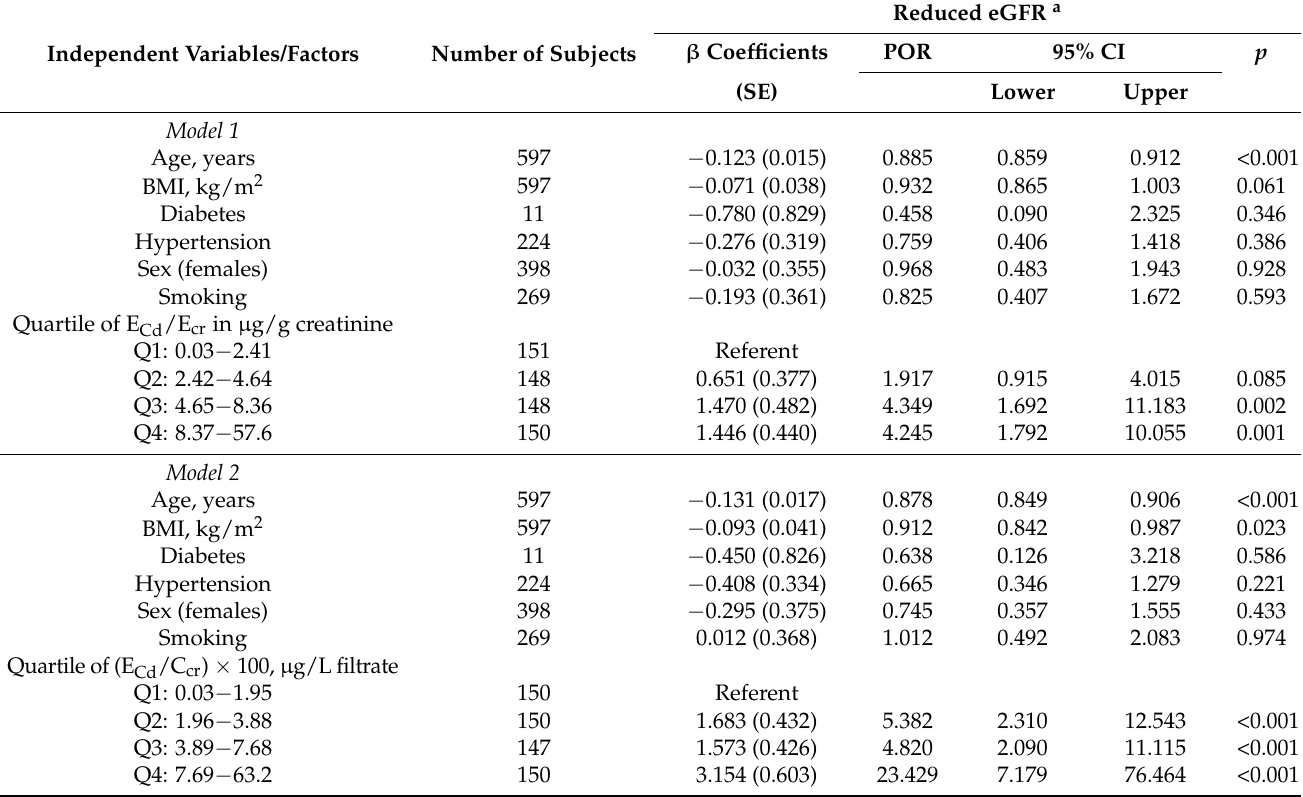
Table 4. Prevalence of reduced eGFR in relation to E Cd quartiles and other